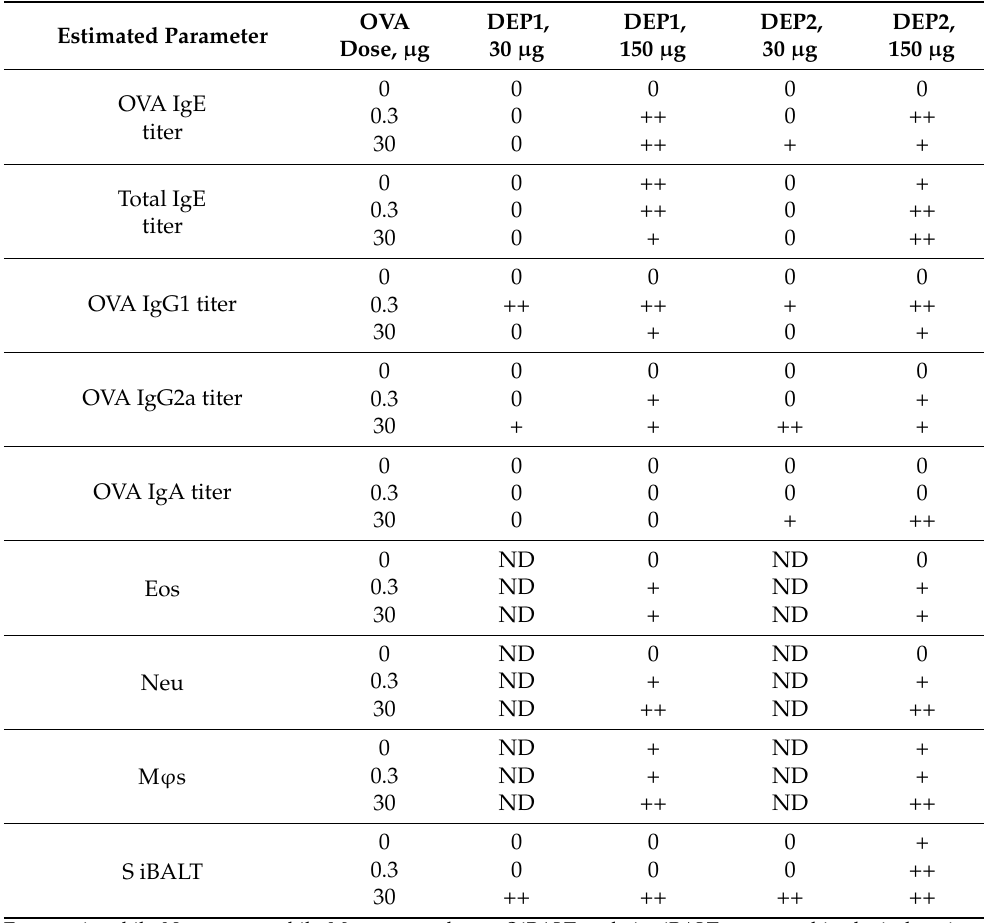
Table 1. The effect of DEPs on antibody production, cellular composition in BAL, and iBALT growth in immunized mice in comparison with those in mice immunized without DEPs with the indicated OVA doses. Estimated Parameter